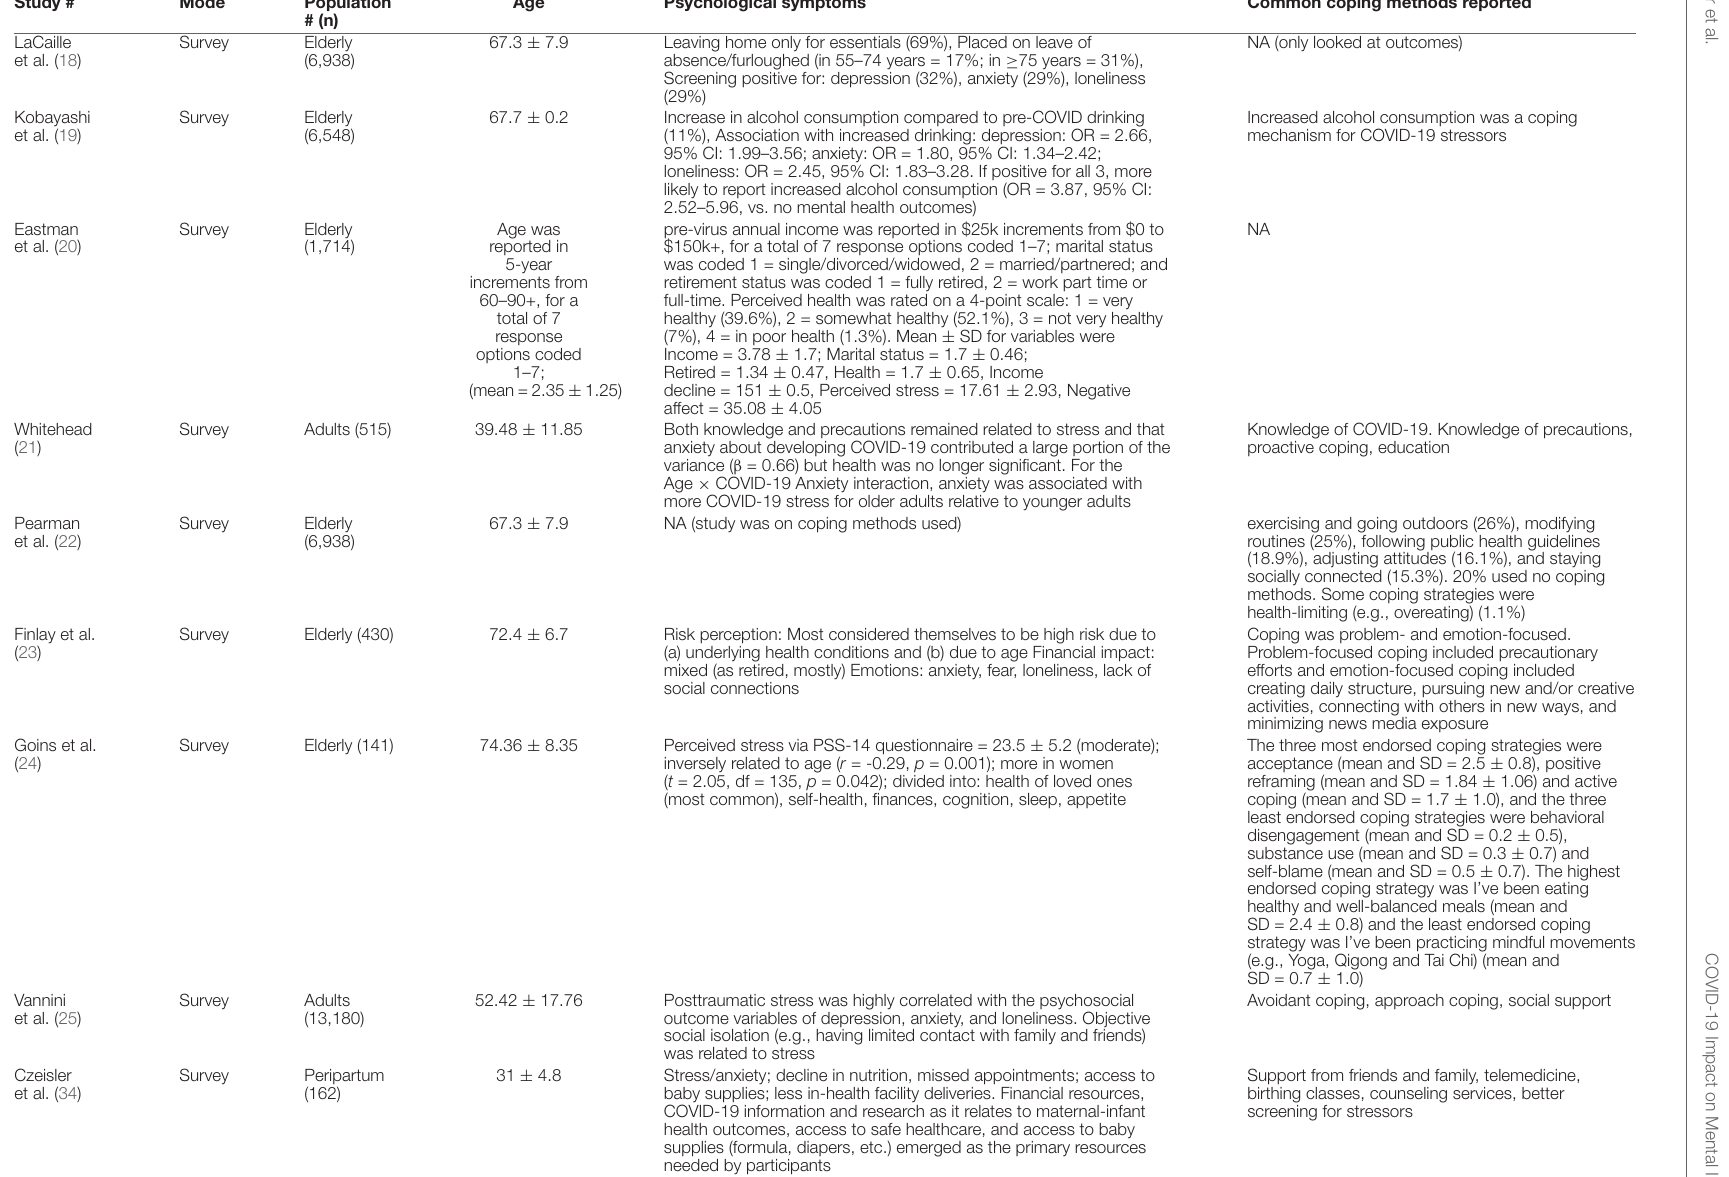
TABLE 2 | An overview of the included studies on elderly populations, pregnant, and